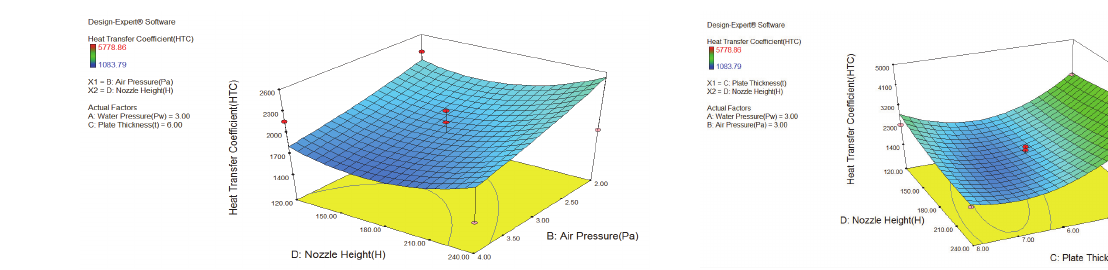
Fig. 7. Variation of HTC with respect to nozzle height and plate